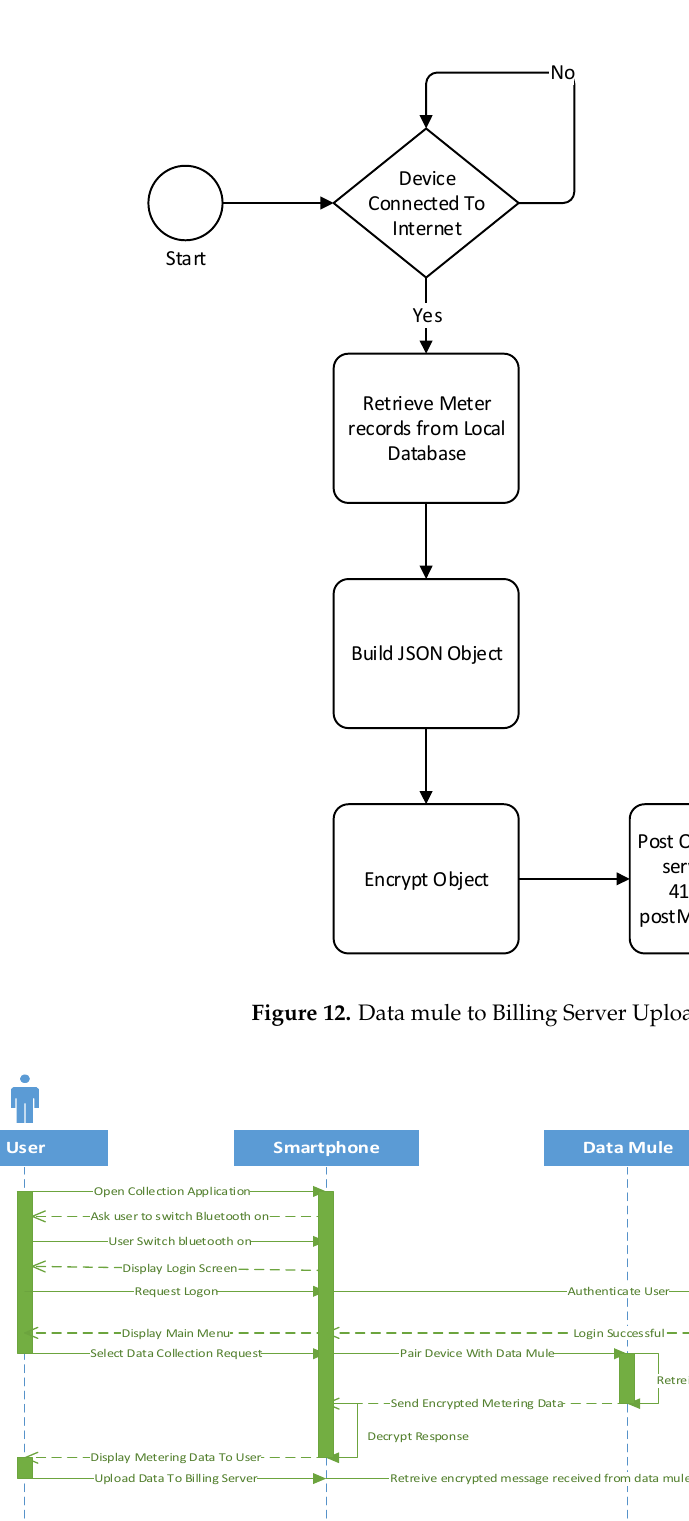
Figure 13. Sequence diagram for retrieving metering data via Bluetooth.